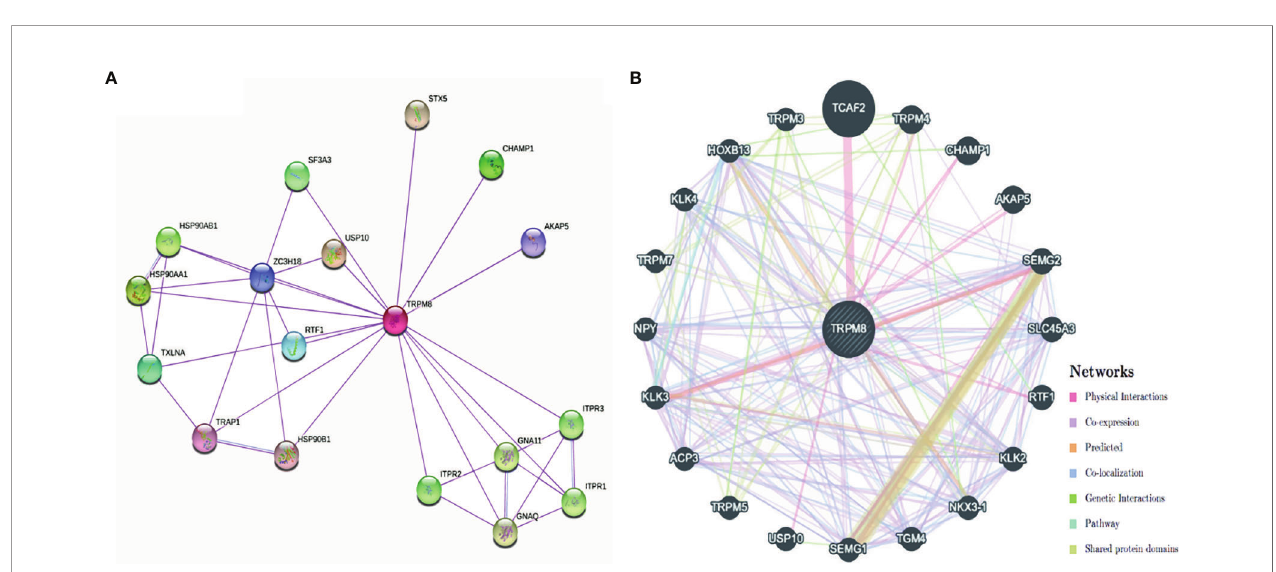
FIGURE 10 | Correlations between TRPM8 and DNA MMR genes and methyltransferases. (A) Correlation between TRPM8 and fi ve MMRs. (B) Correlation between TRPM8 and four methyltransferases. DNMT1 is colored red, DNMT2 blue, DNMT3a green, and DNMT3b purple. *P < 0.05, **P < 0.01, ***P < 0.001.